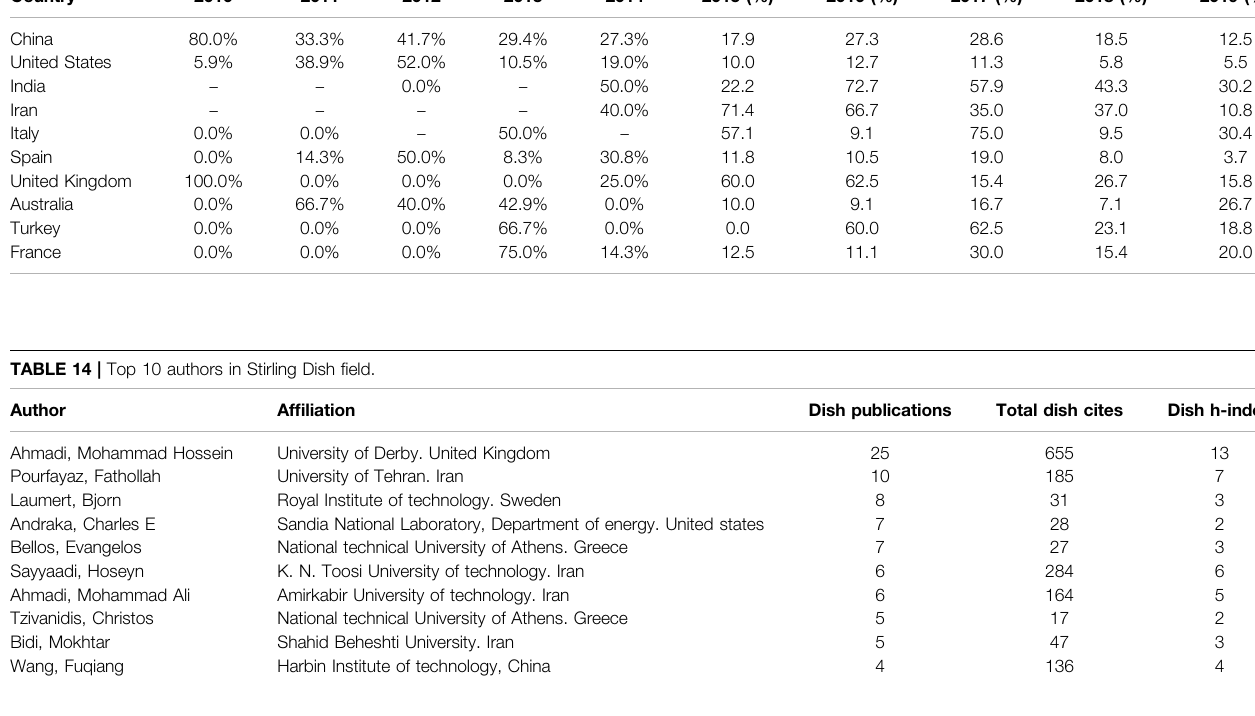
TABLE 13 | Country/region increment of Stirling dish publications compared to those accumulated from the previous year. Country